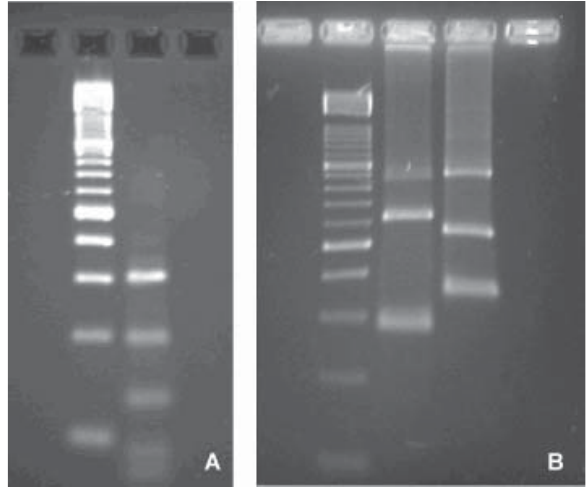
Fig. 4. Restriction analysis of the IGS region of the rDNA amplified by PCR of a Pinus radiata sample, digested with Alu I (A) or with Nde I and Bsm I (B), and electro- phoresed in 3% agarose gel stained with ethidium bro- mide. A) lane 3, pattern obtained with Alu I; B) lanes 3 and 4, patterns obtained with Bsm I and Nde I, respec- tively. Lane 2 both in A and B contains a 100 pb DNA molecular marker as a size